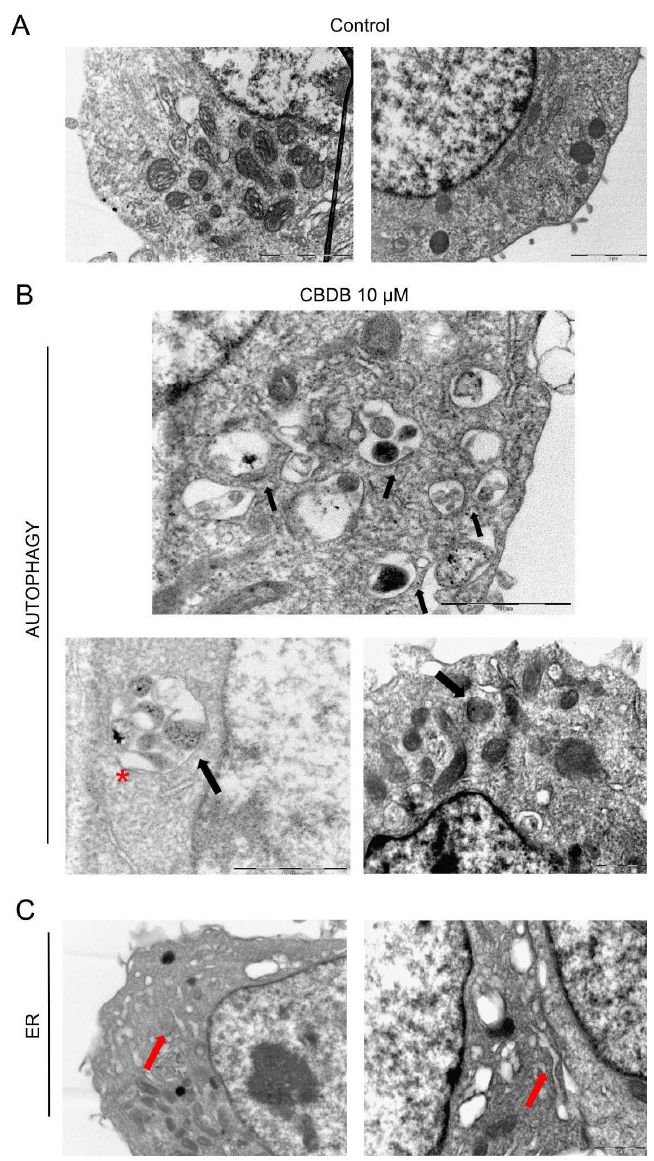
Figure 6. Representative TEM images of cell morphology. ( A ) MCF-7 control cells (treated with DMSO, as vehicle). Scale bar 2 µm. ( B , C ) MCF-7 cells fixed exposed to CBDB or CBDP (10 µM) for 24 h; ( B ) double-membrane autophagic vacuoles red asterisk, autophagosomes black arrows, ( C ) outstretched ER black arrows.